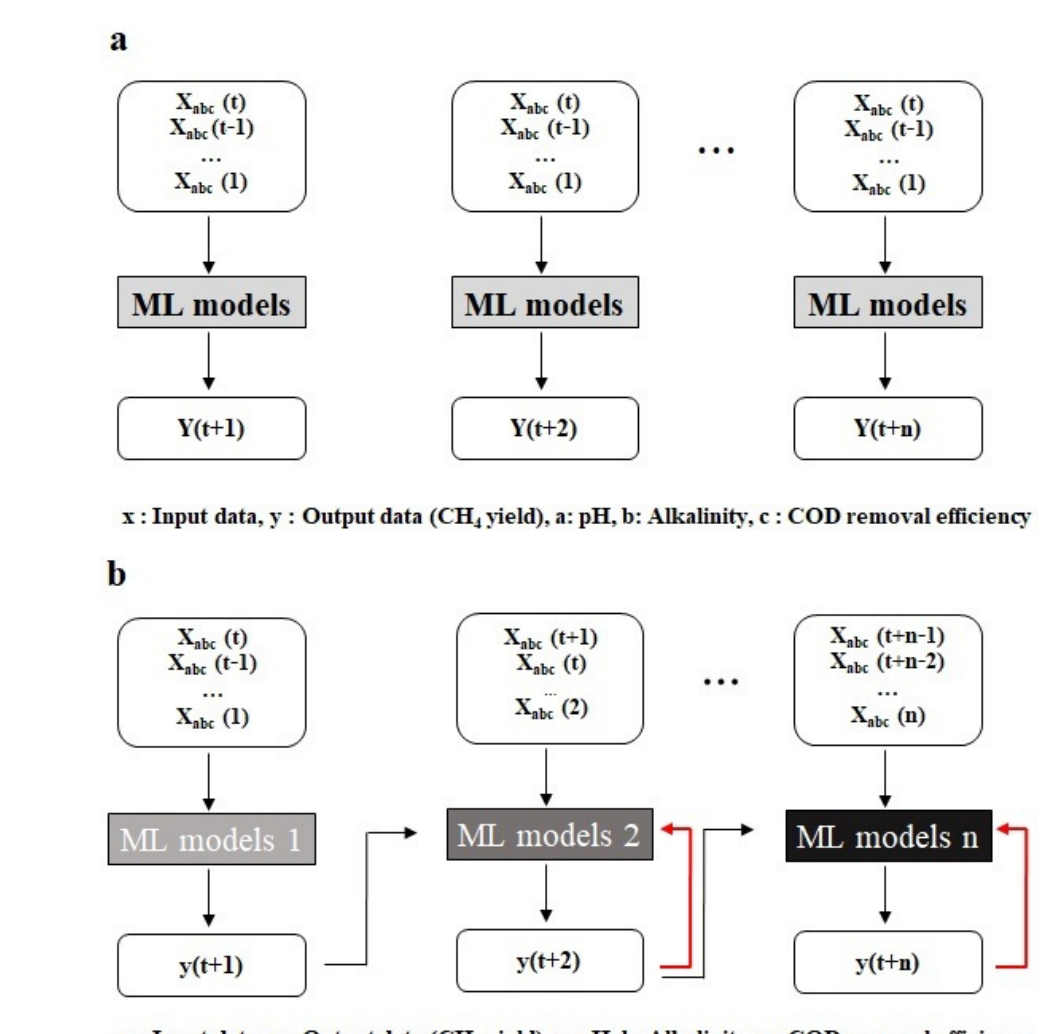
Figure 1. Schematic diagrams for understanding the ( a ) machine learning algorithm, ( b ) multi-step ahead method, and ( c ) 1-step ahead with retraining method [21].